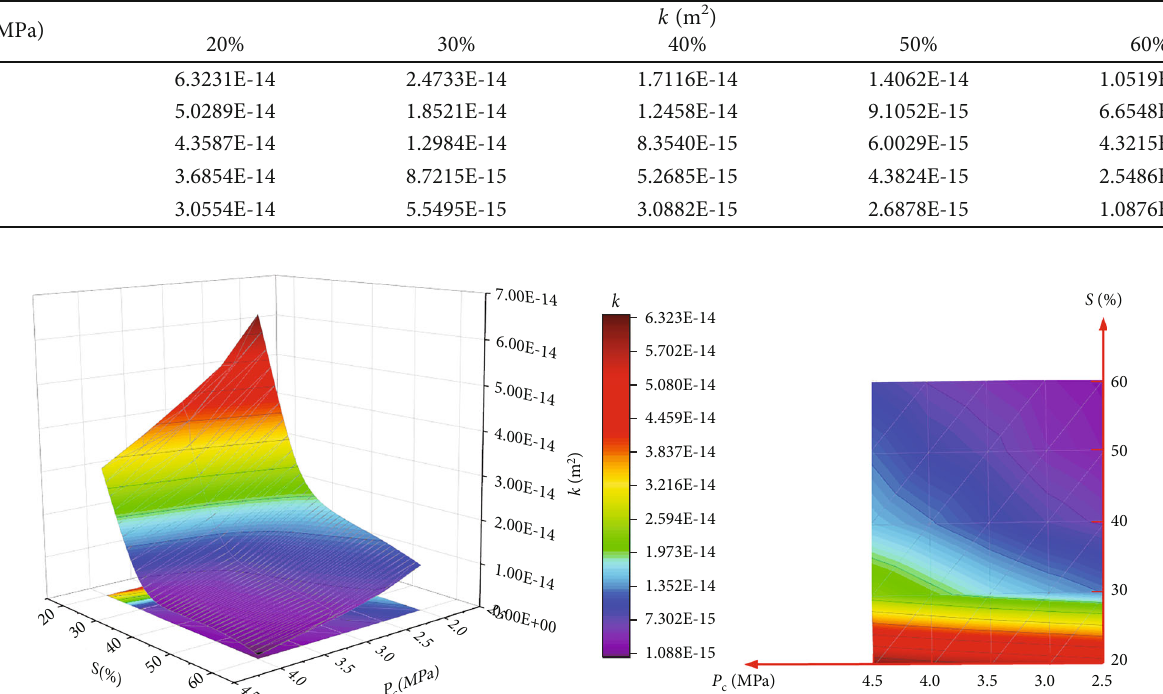
ff erent clay mineral proportions S c under di